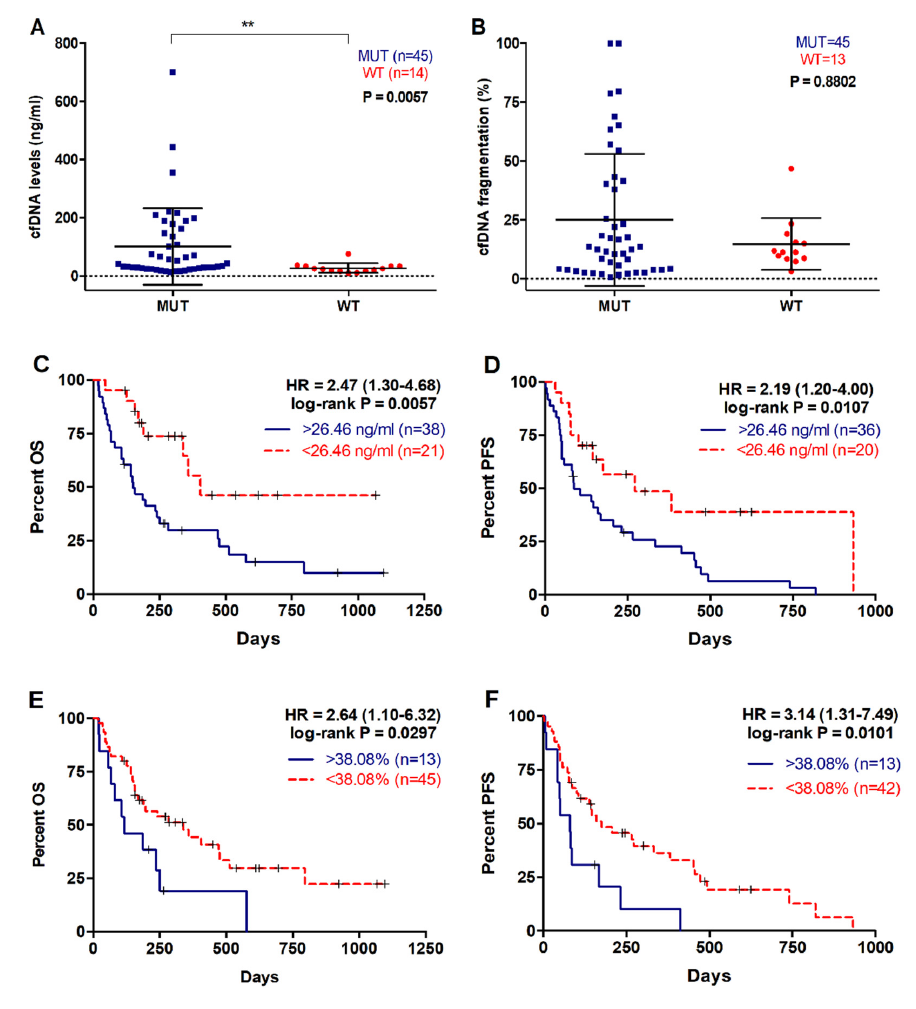
Figure 5. cfDNA concentration and fragmentation in metastatic PDAC patients. ( A ) cfDNA levels and ( B ) fragmentation according to RAS mutational status; ( C ) OS according to cfDNA levels (cut-o ff : 26.46ng / mL); ( D ) PFS according to cfDNA levels (cut-o ff : 26.46ng / mL); ( E ) OS according to cfDNA fragmentation (cut-o ff : 38.08%); ( F ) PFS according to cfDNA fragmentation (cut-o ff : 38.08%). (** p <